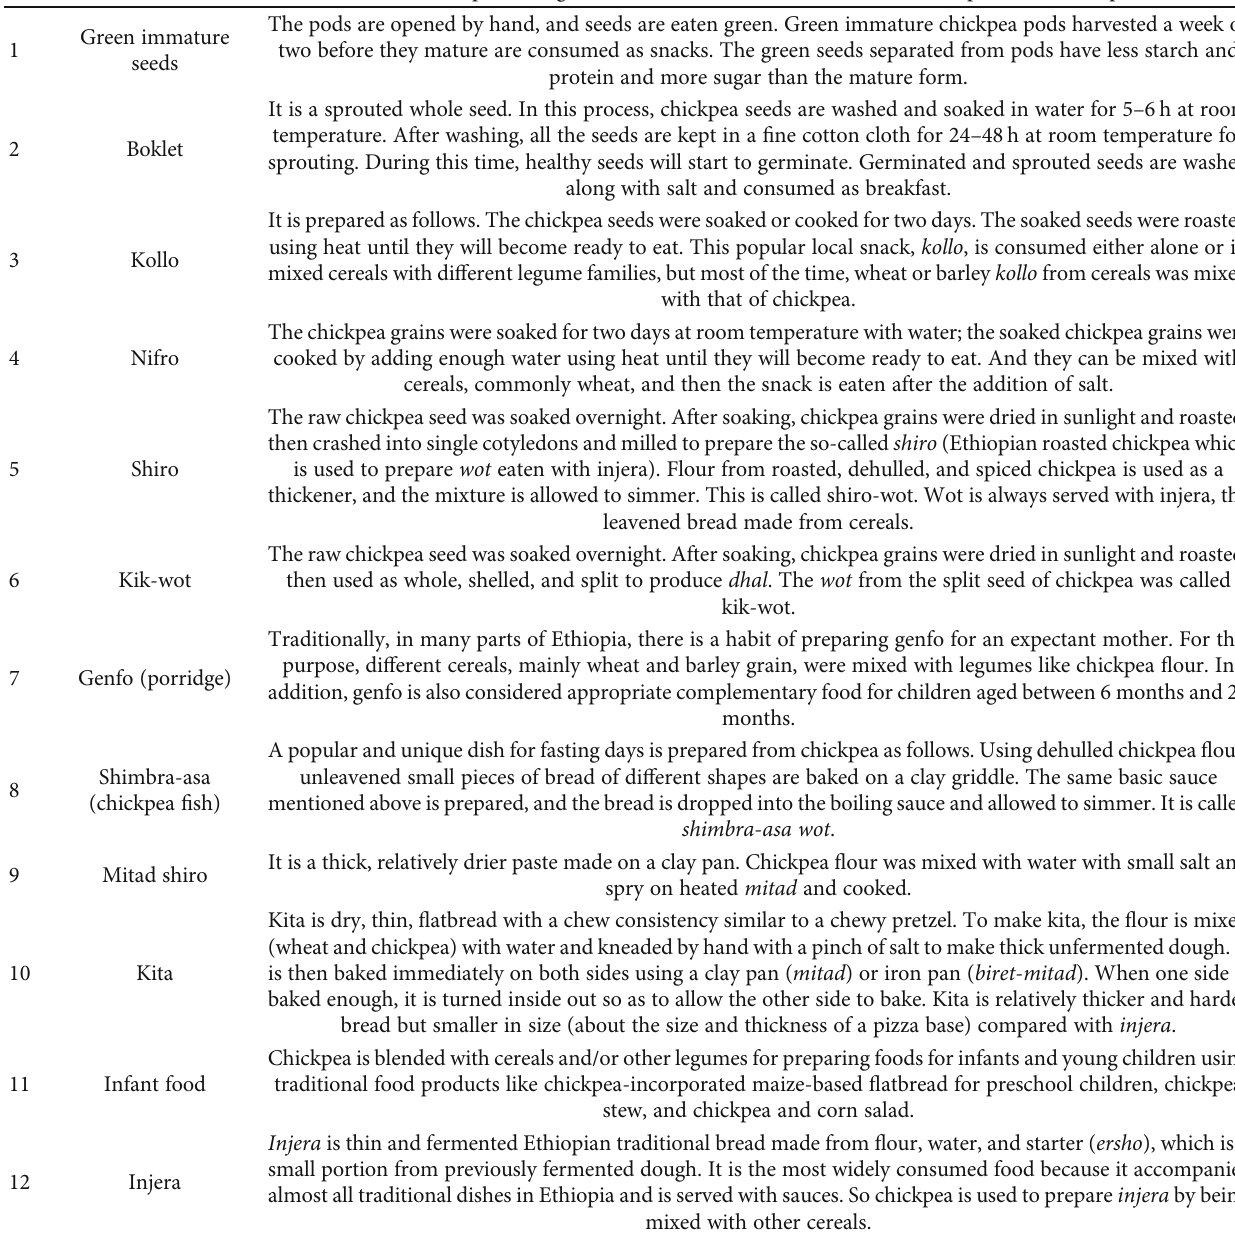
Table 6: Di ff erent Ethiopian traditional chickpea-based food products and their preparation mechanisms for utilization. No. Product name Characteristics, processing conditions, and mode of utilization of chickpea-based food products Green